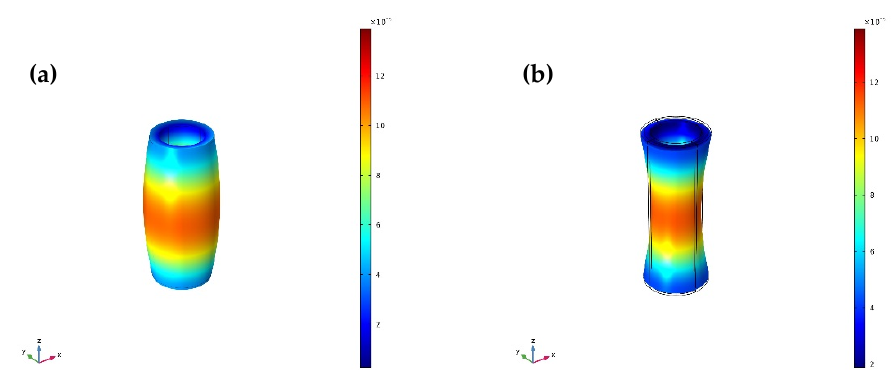
Figure 8. Vibrational mode of the No. 1 transducer with 1 =5 τ at the fundamental mode ( f r 1 = 33,997 Hz): ( a ) expansion; ( b ) shrinkage.